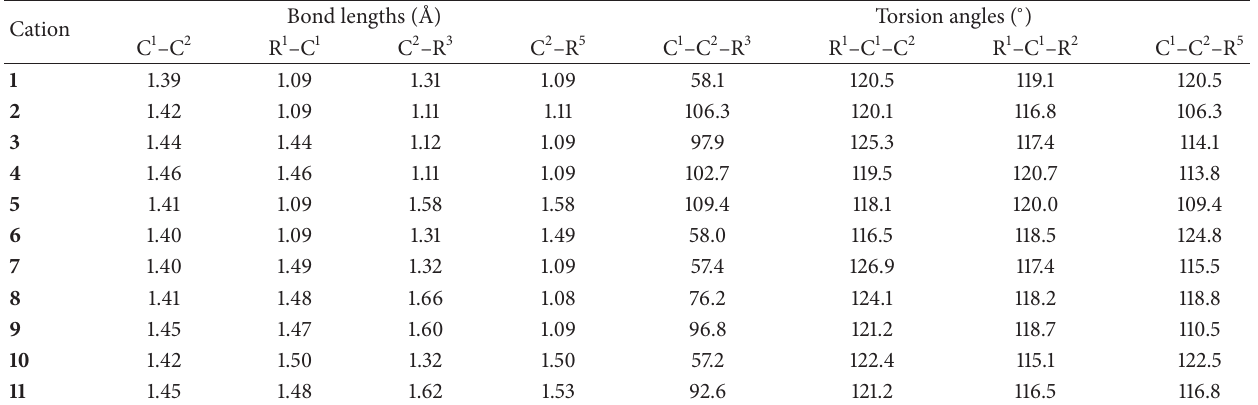
Table 2: Calculated structural parameters for multisubstituted ethyl cations 1 – 11 . Selected bond lengths are in angstrom (˚A) and selected torsion angles in degrees ( ∘